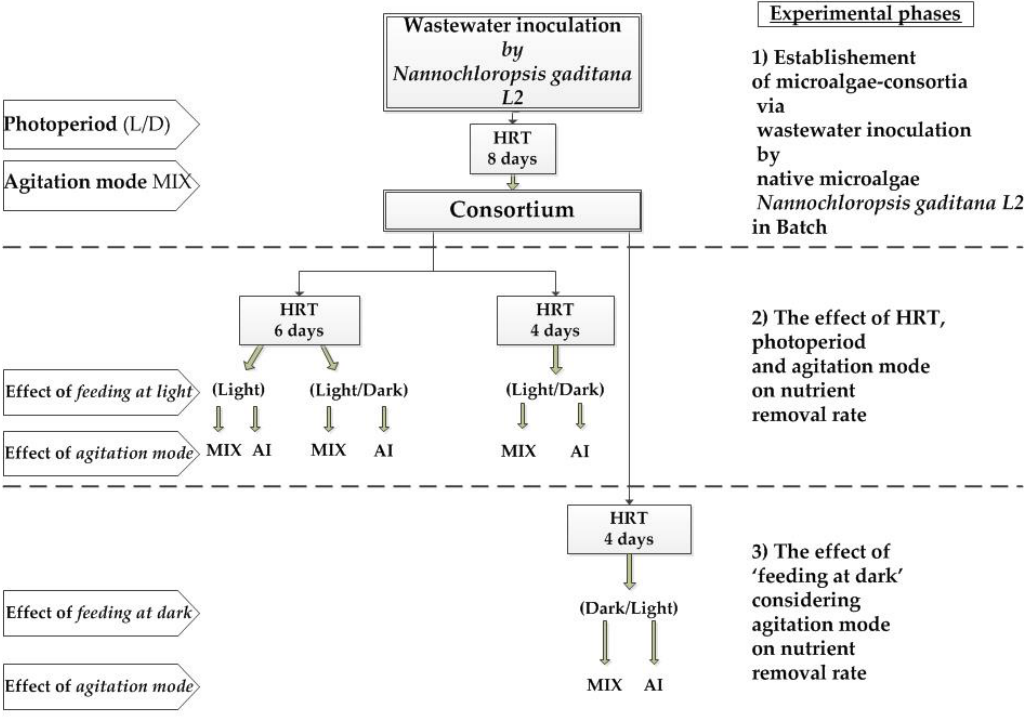
Figure 2. Diagram of experiments carried out in this work. Three experimental phases related to the evaluation of the main studied parameters in sequencing batch reactor (SBR) treating wastewater (WW) by microalgae-based consortium: HRT, agitation mode, and the e ff ect of feeding